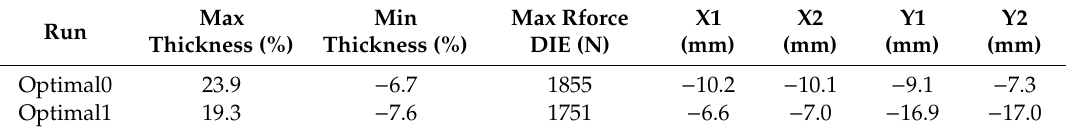
Table 10. Output for optimal models: blank0 (optimal0) and blank 1 (optimal1).